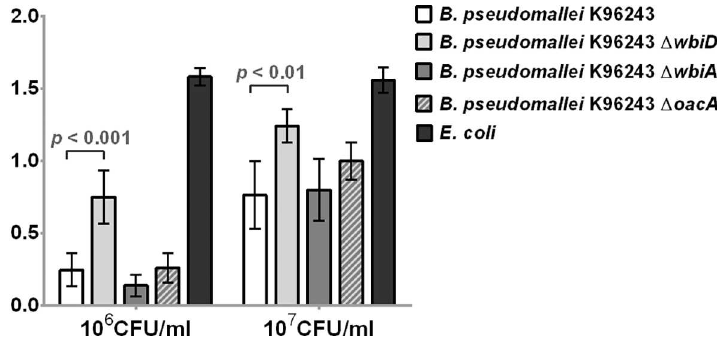
Fig 9. Activation of NF- κ B in HEK-Blue hTLR4 cells by heat-killed wild type K96243 and mutant containing unmarked deletions of wbiD , wbiA , and oacA . HEK-Blue hTLR4 cells were stimulated with heat-killed bacteria at 10 6 or 10 7 CFU/ml at 37˚C in 5% CO 2 for 24 h. The positive control was E . coli ATCC 25922. NF- κ B activation was determined in the supernatant by a SEAP reporter assay. Mean ± SD of two independent experiments were